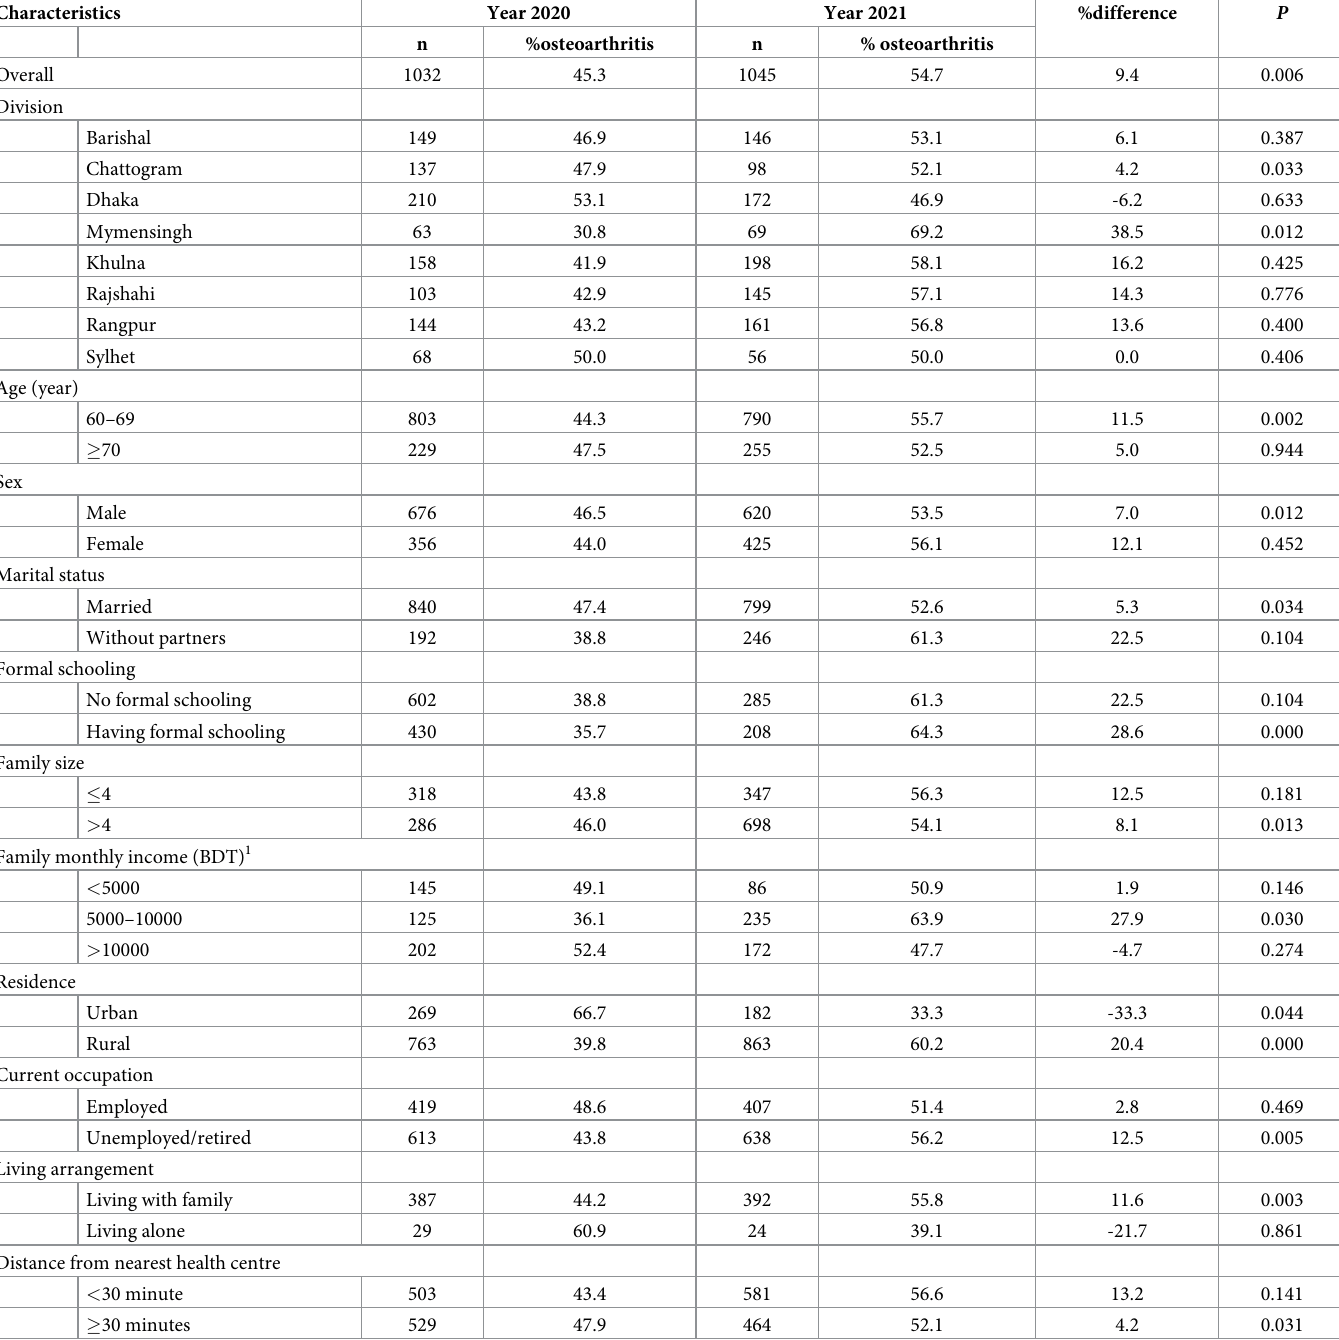
Table 2. Changes in prevalence of osteoarthritis over time (n = 2077).